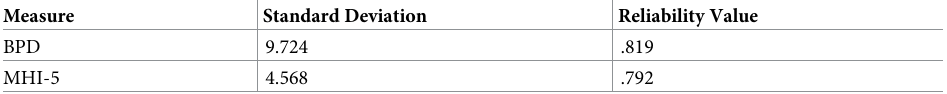
Table 1. Standard deviations and reliability values for calculating reliable change